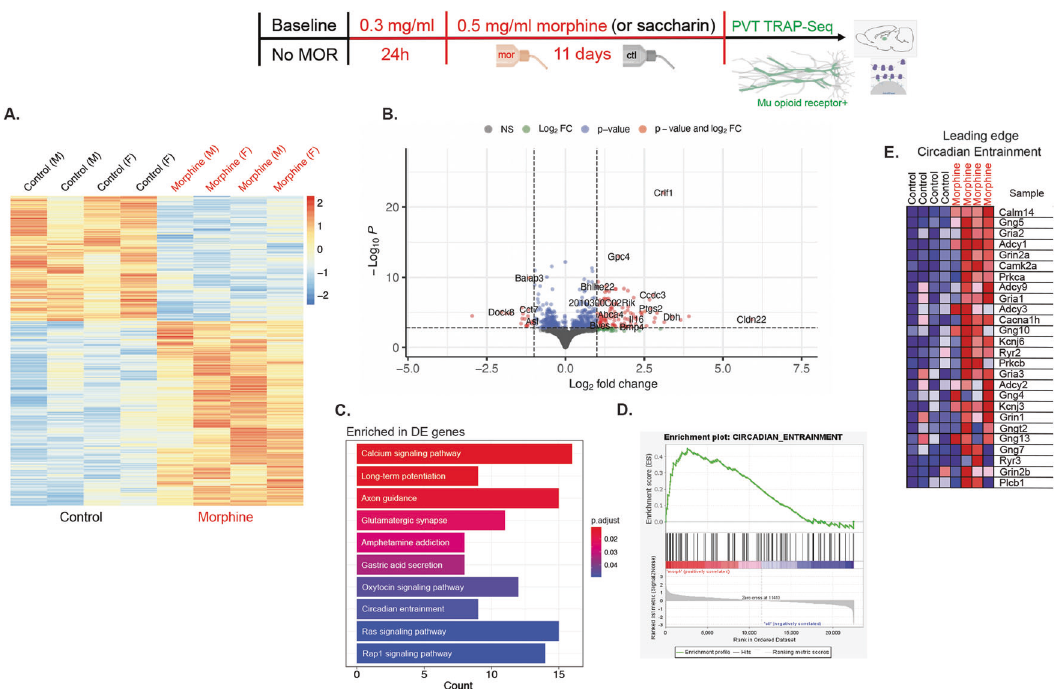
Fig. 4 Translating ribosome af fi nity puri fi cation on MOR-expressing neurons targeted at the paraventricular nucleus of the thalamus. A Heatmap of signi fi cantly differentially expressed genes in PVT MOR-expressing neurons of controls compared to mice maintained on chronic morphine. B Volcano plot showing − log10 P value vs log2 fold change (morphine vs ctl group) for all genes analyzed. Genes corresponding to signi fi cant adjusted P values are those above the dashed horizontal line. Dashed vertical lines correspond to a threshold of 1 for the absolute log2 fold change. C Signi fi cant KEGG pathways from ORA analyses of DE genes. D Enrichment plot of the Circadian Entrainment pathway. E Heatmap of the genes in the leading edge of the Circadian Entrainment pathway.